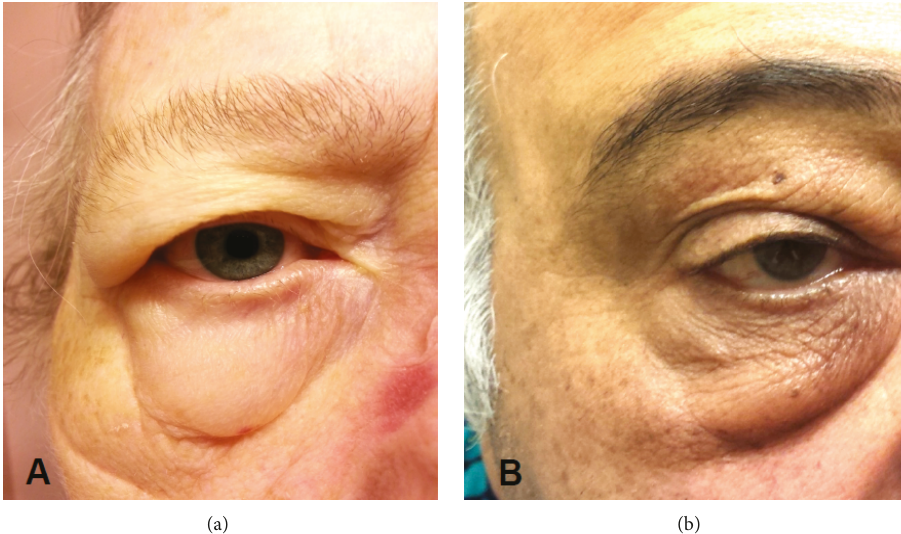
Figure 1: Two patients with periorbital edema after initiating PAP therapy via a full face mask. Periorbital edema developed after starting PAP therapy via a full face mask in patient A in 11 days and patient B in 2